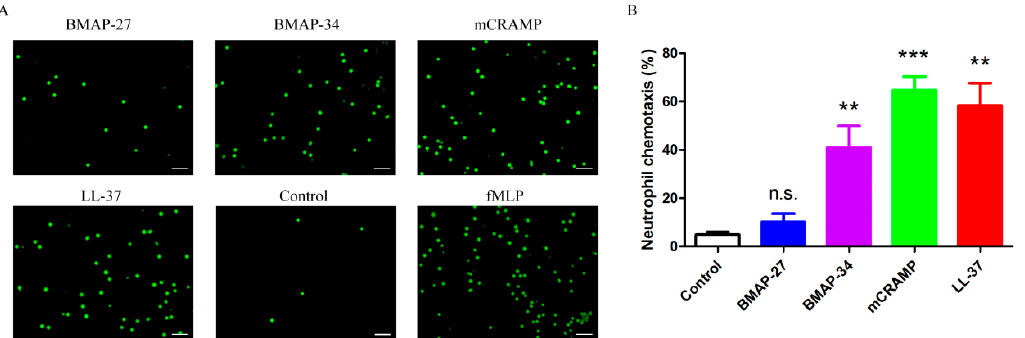
Figure 6. Mammalian cathelicidins BMAP-34, mCRAMP and LL-37 stimulate the chemotaxis of neutrophils. ( A ) Fluorescence microscopic analyses for the chemotactic properties of BMAP-27, BMAP-34, mCRAMP and LL-37. Human neutrophils (green) were seeded in the upper chamber of a 5 μ m Transwell, migration was stimulated with each peptide in the lower chamber. Control, untreated neutrophils. N-Formyl-methionyl-leucyl-phenylalanine (fMLP) at 5 μ M was used as positive control. Scale bars = 25 μ m. ( B ) Neutrophil chemotaxis was calculated using the number of migrating neutrophils attracted by positive control fMLP as 100%. Values represent the mean ± SD from three independent assays, ** P < 0.01, *** P < 0.001, n.s. = not significant.